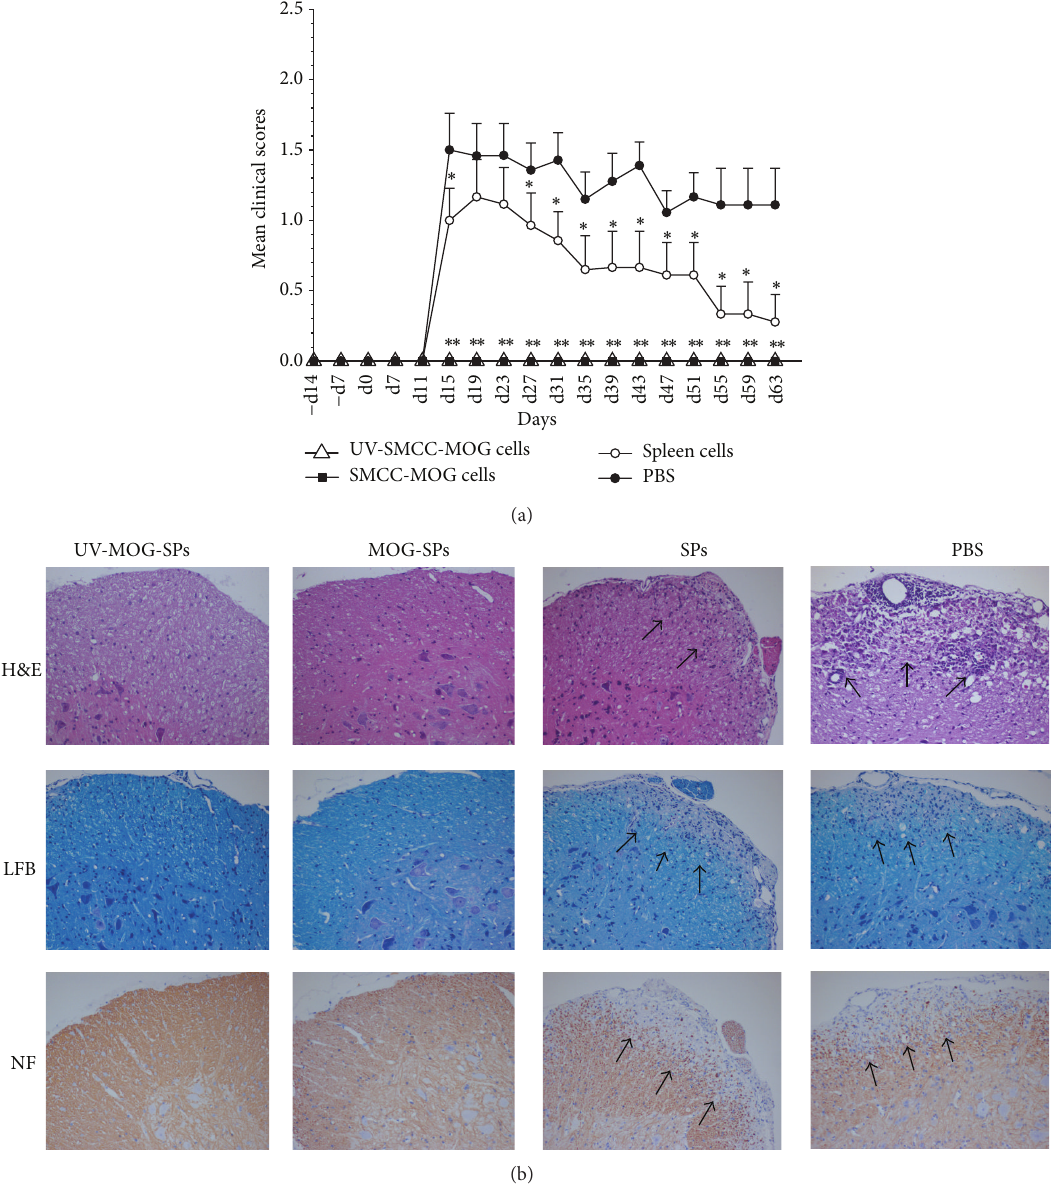
Figure 1: Effect of preadministration of MOG-coupled spleen cells on preventing EAE. (a) Female C57BL/6 mice were immunized with peptide (200 𝜇 g) emulsified in CFA containing Mycobacterium tuberculosis H37Ra on day 0. The mice received i.p. injection of MOG 35 – 55 200 ng pertussis toxin on day 0 and day 2. Mice were randomly divided into four groups (10 mice/group) and given intravenous injection of 1 × 10 7 different cells (UV-MOG-SPs, MOG-SPs, and SPs) or the same volume of PBS before EAE induction (designated as − d14 and − d7) and after EAE induction (days 0 and +7). All mice were monitored daily for over 2 months. The scores of treatment groups were compared with the scores of PBS treated group at each time point. ∗ 𝑝 < 0.05 ; ∗∗ 𝑝 < 0.01 . (b) Histology examination of spinal cords from the mice receiving the treatments above was performed on day 30 (4 mice/group). H&E (upper panel), LFB (middle panel), and NF staining (bottom panel) were performed to examine mononuclear infiltration, demyelination, and axonal injury in the lumbar spinal cords. Original magnification × 20. The arrows showed a stronger infiltration, increased demyelination, and more axonal loss in SPs and PBS treated groups compared with MOG-coupled spleen cells treatment. Similar data were obtained from two additional independent